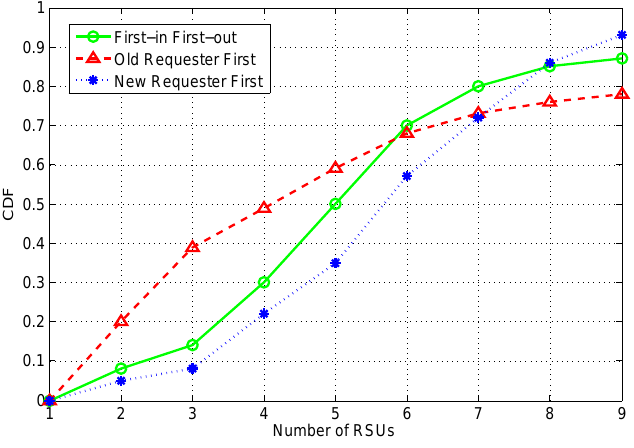
Figure 12. Cumulative distribution functions with different